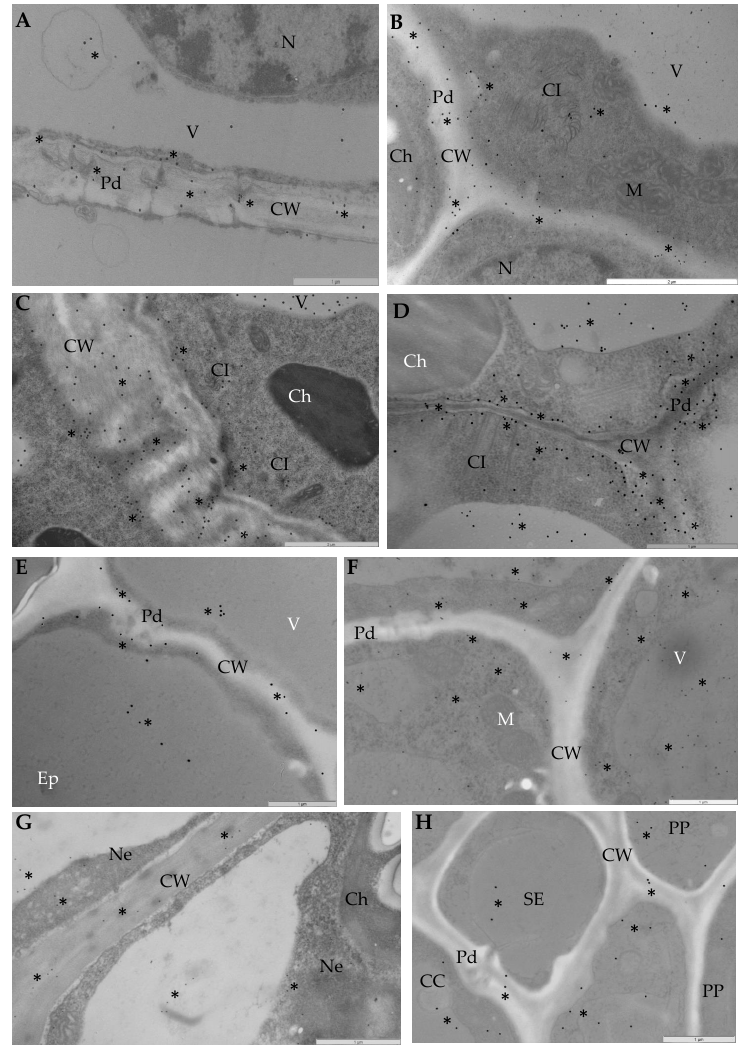
Figure 4. Immunogold localization of expansins in compatible ( B – D ) and incompatible ( F – H ) PVY NTN –potato interactions. ( A ) StEXPAs (*) in mock-inoculated mesophyll cells in the cell wall, around the plasmodesmata, in the cytoplasm, and in vacuoles; bar 1 µ m. ( B ) StEXPAs (*) in the cell wall, plasmolemma, cytoplasm, and vacuoles in phloem parenchyma cells at 14 days post-virus inoculation. Virus cytoplasmic inclusion in cytoplasm; bar 2 µ m. ( C ) StEXPAs (*) in the changed cell wall, plasmolemma, vacuoles, and cytoplasm of mesophyll cells at 30 days post-virus inoculation. Virus cytoplasmic inclusion in cytoplasm; bar 2 µ m. ( D ) StEXPAs (*) in the cell wall, around the plasmodesmata, and along the plasmalemma of mesophyll cells at 30 days post-inoculation. Virus cytoplasmic inclusion was next to the plasmodesmata, and gold deposition was also observed in the cytoplasm and vacuoles; bar 1 µ m. ( E ) StEXPAs (*) in the cell wall and around the plasmodesmata in mock-inoculated S á rpo Mira epidermis cells. Gold deposition was also observed in vacuoles; bar 1 µ m. ( F ) StEXPAs (*) in the cell wall, cytoplasm, and vacuoles of phloem cells at 14 days post-virus inoculation; bar 1 µ m. ( G ) StEXPAs (*) in the cell wall, cytoplasm, and vacuoles in mesophyll necrotized cells at 30 days post-virus inoculation; bar 1 µ m. ( H ) StEXPAs (*) in the cell wall, cytoplasm, and vacuoles of phloem cells at 30 days post-virus inoculation; bar 1 µ m. CC—companion cell;